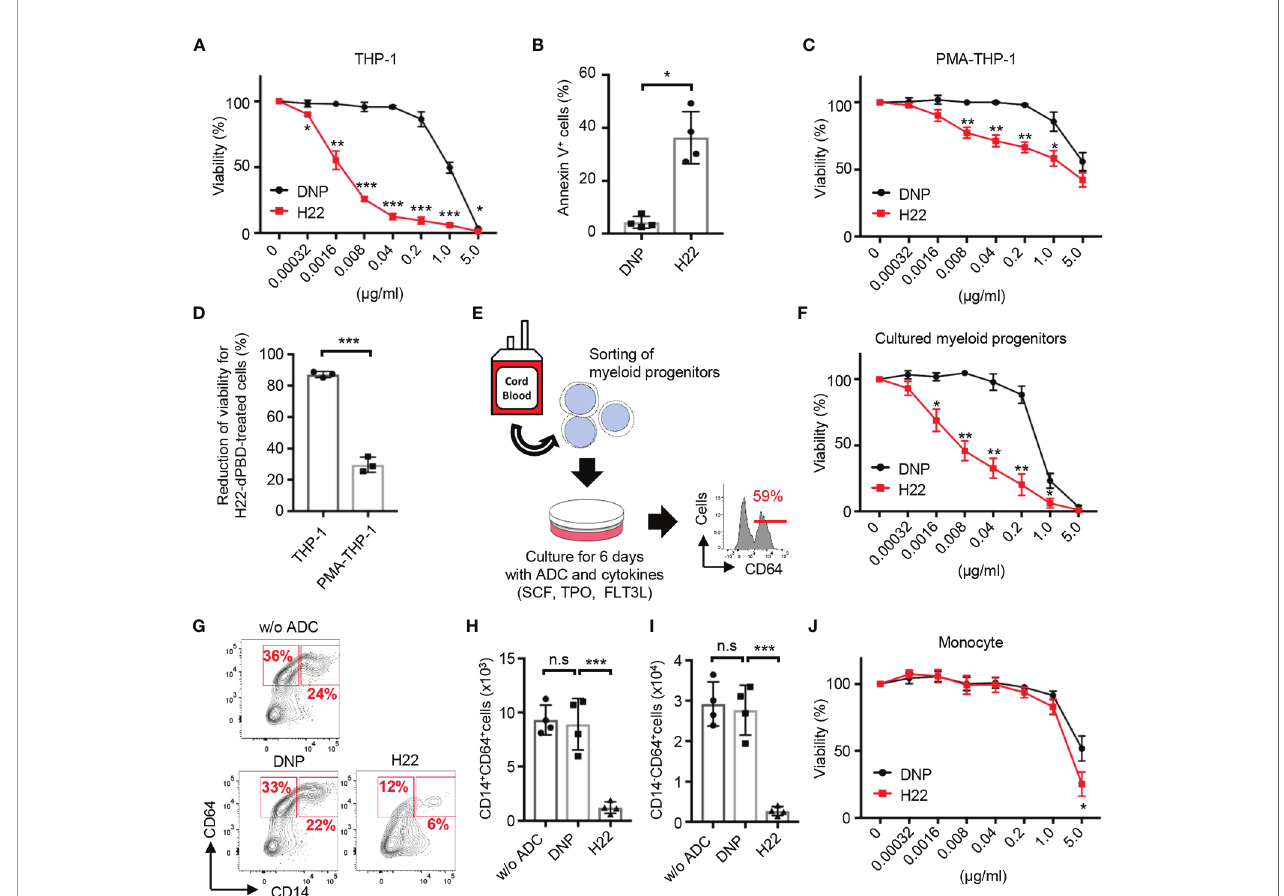
FIGURE 3 | Preferential cytotoxic activity of H22-dPBD against monocytic progenitors, but not monocytes. (A) Evaluation of cytotoxic activity of H22-dPBD against THP-1 cells. THP-1 cells were cultured for 6 days in the presence of DNP-dPBD or H22-dPBD and their relative viability was estimated based on the quanti fi cation of ATP (n=3). (B) Induction of apoptosis by H22-dPBD. THP-1 cells were cultured with ADCs (0.04 µg/ml) for 3 days and the frequency of apoptotic cells was evaluated by FCM (n=4). (C) Killing activity of H22-dPBD against PMA-treated THP-1 cells. THP-1 cells were stimulated with 40 ng/ml PMA for 24 h prior to culture with the ADC and the susceptibility of cells to H22-dPBD was examined as shown in (A) (n=3). (D) Killing ef fi cacy of H22-dPBD treatment against THP-1 cells and PMA-treated THP-1 cells. Normalized reduction of cell viability was calculated from the data of treatment with 0.04 m g/ml ADCs in (A) and (C) (n=3). (E) Experimental scheme of the killing assay against myeloid progenitors. Lin - CLEC12A + myeloid progenitors were sorted from UCB and were cultured with ADCs and cytokines (100 ng/ml SCF, 50 ng/ml TPO and FLT3L). The number on the histogram indicates the mean frequency of CD64 + progenies yielded through 6-day culture (n=3). (F) Cytotoxic activity of H22-dPBD against cells generated from Lin - CLEC12A + progenitors at day 6. Relative viability was assessed based on the quanti fi cation of ATP (n=3). (G – I) FCM analysis of CD64 + cells from Lin - CLEC12A + myeloid progenitors. Cells were cultured with cytokines and 0 or 0.008 µg/ml ADC for 6 days and the numbers of CD14 + monocytes (H) and CD14 - CD64 + monocytic progenitors (I) were determined. (J) Cytotoxic activity of H22-dPBD against mature monocytes. CD14 hi CD16 - monocytes were sorted from the peripheral blood of healthy donors and were cultured for 6 days in the presence or absence of ADC (n=4). The data were pooled from three (A, D) or four (B, J) independent experiments or are representative of two (F) or three (C, E, G – I) independent experiments. Multiple t -test (A, C, F, J), Student ’ s t -test (B, D) and one-way ANOVA (H, I) were used to assess statistical signi fi cance. Error bars represent standard deviation of the mean. * p < 0.05, ** p < 0.01, *** p < 0.001; n.s, not signi fi